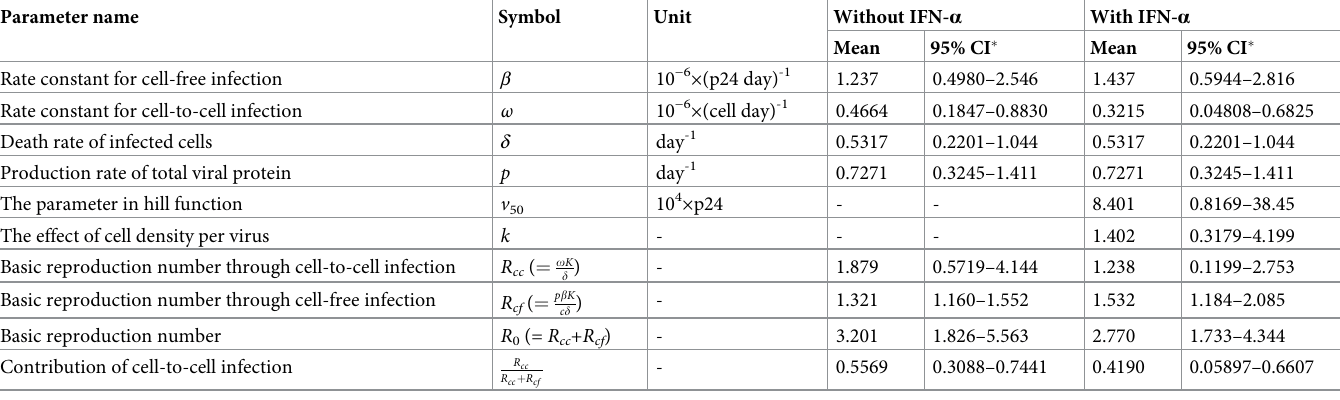
Table 3. Estimated parameters fitting the experimental data of HIV-1 strain CH077_TF by Model 1.